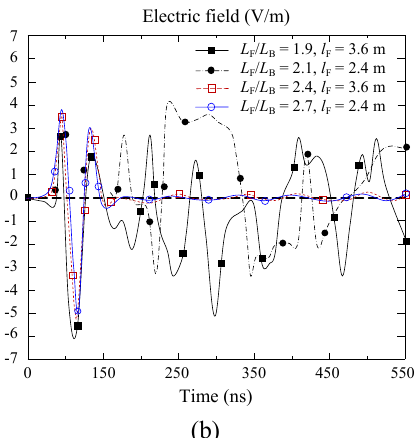
Figure 19: (a) Reflectivity comparison between existing ab- sorbers and the proposed one and (b) electric field variation in the dual reflector chamber for different dimension ratios, sizes and heights of the quiet zone.